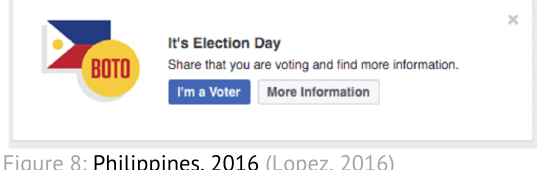
Figure 8: Philippines, 2016 (Lopez, 2016)